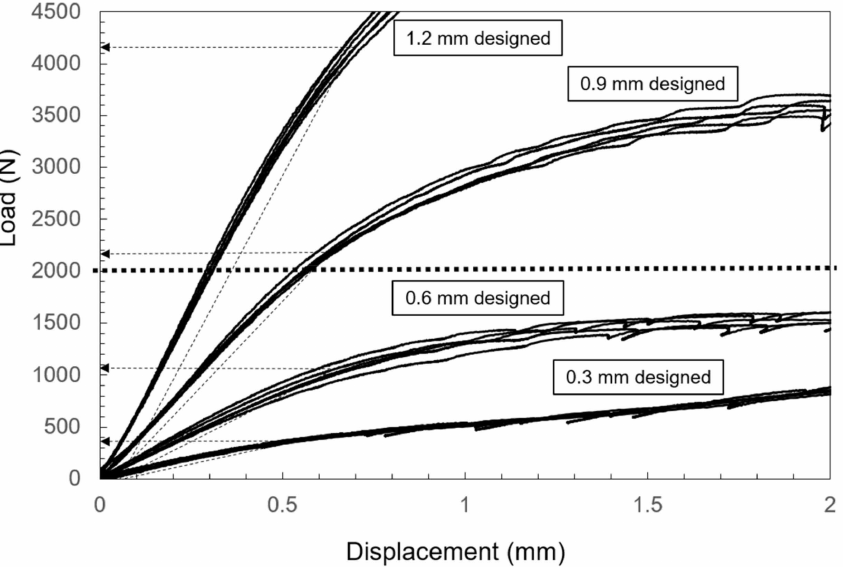
Figure 7. Load–displacement curve from the bending test of tray-shaped VT specimens. Little plastic deformation is observed in the 0.9- and 1.2 mm thick specimens at 2000 N. The dot arrows indicate the average of the 0.2% offset load. The dot line indicates 2000 N to be the assumed occlusal